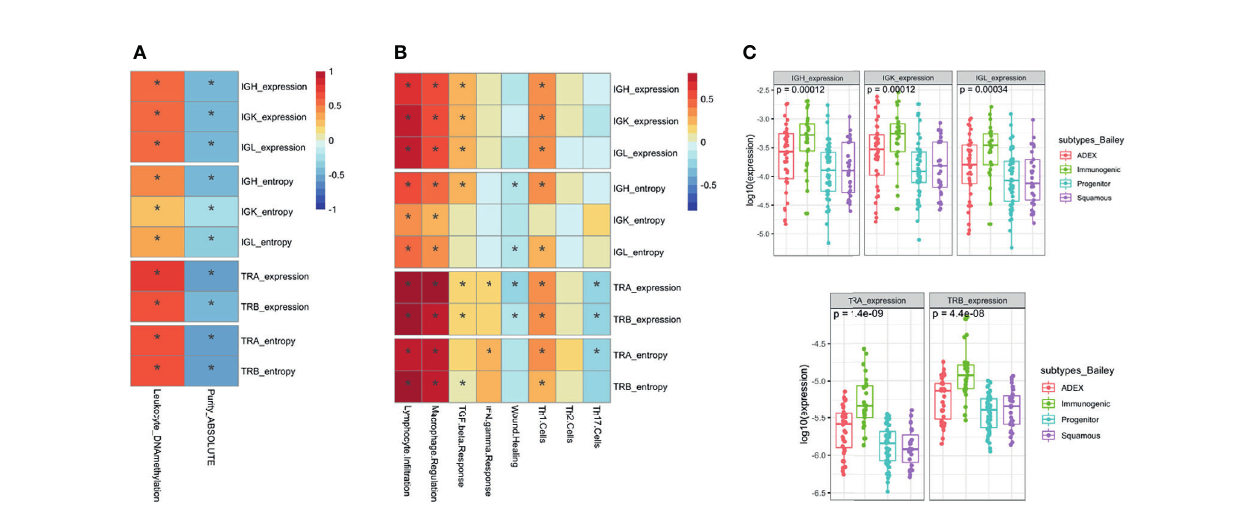
FIGURE 4 | Association analysis with molecular and immune characteristics. Pearson correlation (A) with the association between the immune repertoire features and tumor purity and leukocyte DNA methylation measures. Pearson correlation (B) between the IG and TCR features with immune expression signatures and characteristics. The * shows if the correlation is signi fi cant (FDR < 0.05). Boxplots with the association between IG and TCR with subtypes of pancreatic cancer using a Wilcoxon test (C)